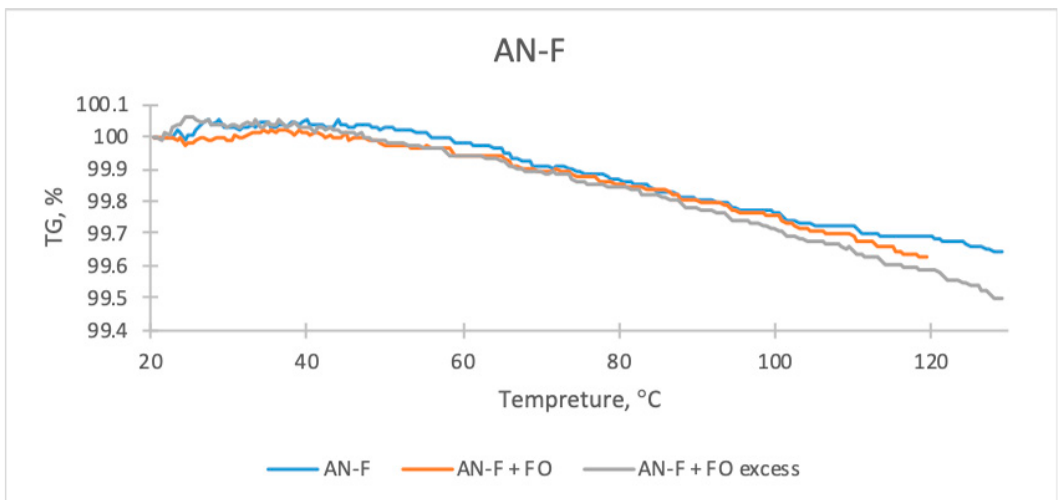
Figure 5. TG results of